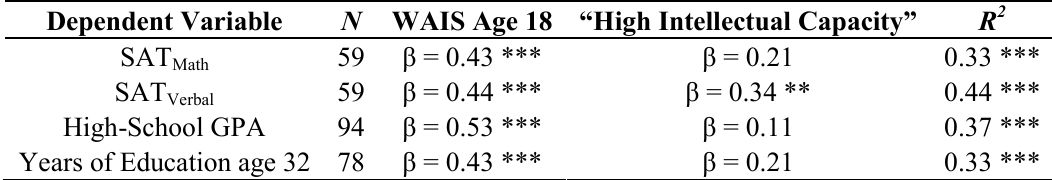
Table 5. Regression analyses predicting future intellectual ability and scholastic outcomes from age 18 IQ and “high intellectual capacity” rating as judged at ages